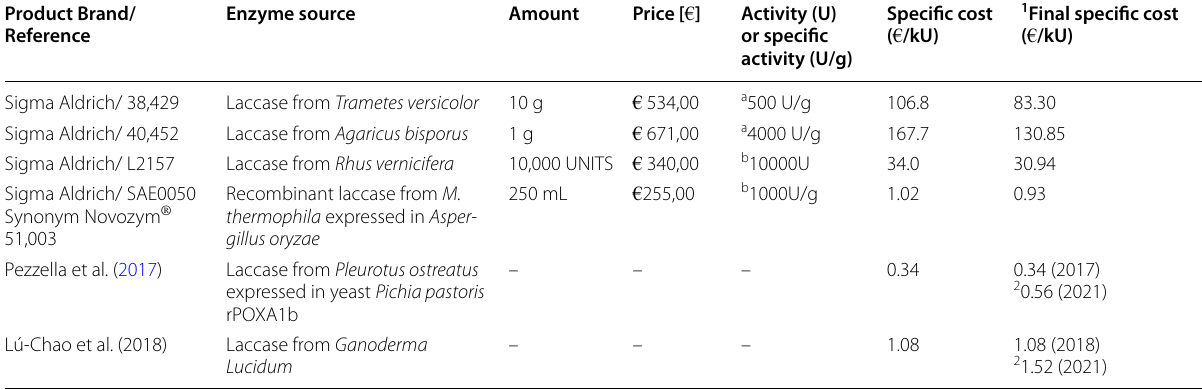
Table 3 Cost of different commercial laccases and laccases produced by researchers in scale-up